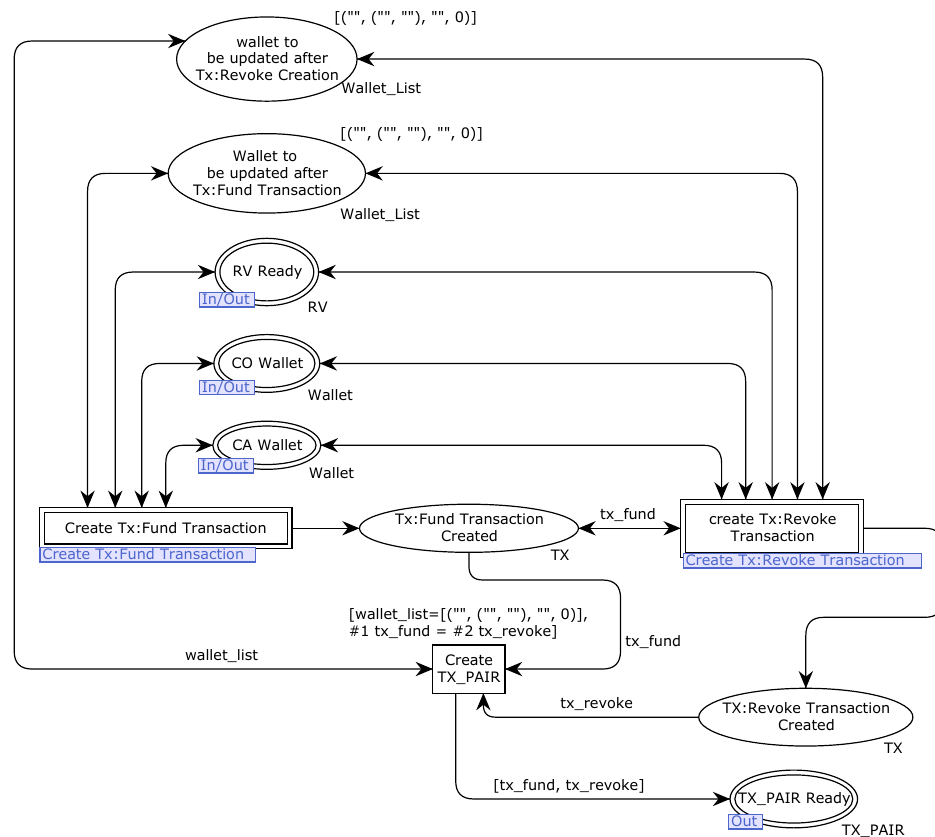
Figure 11. ‘Create Revocation Transactions’ sub-module of the BlockVoke CPN